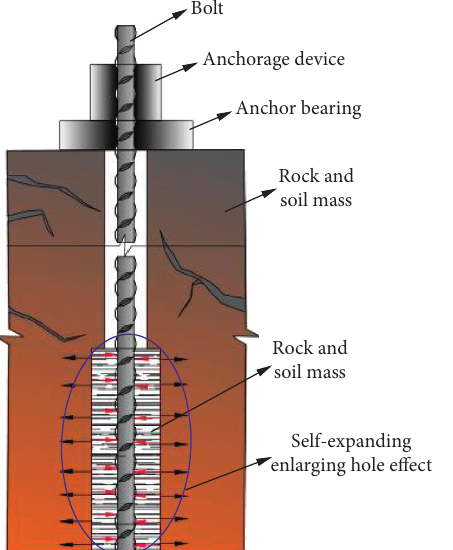
Figure 1: Schematic diagram of self-expanding, high-strength, precompression anchoring